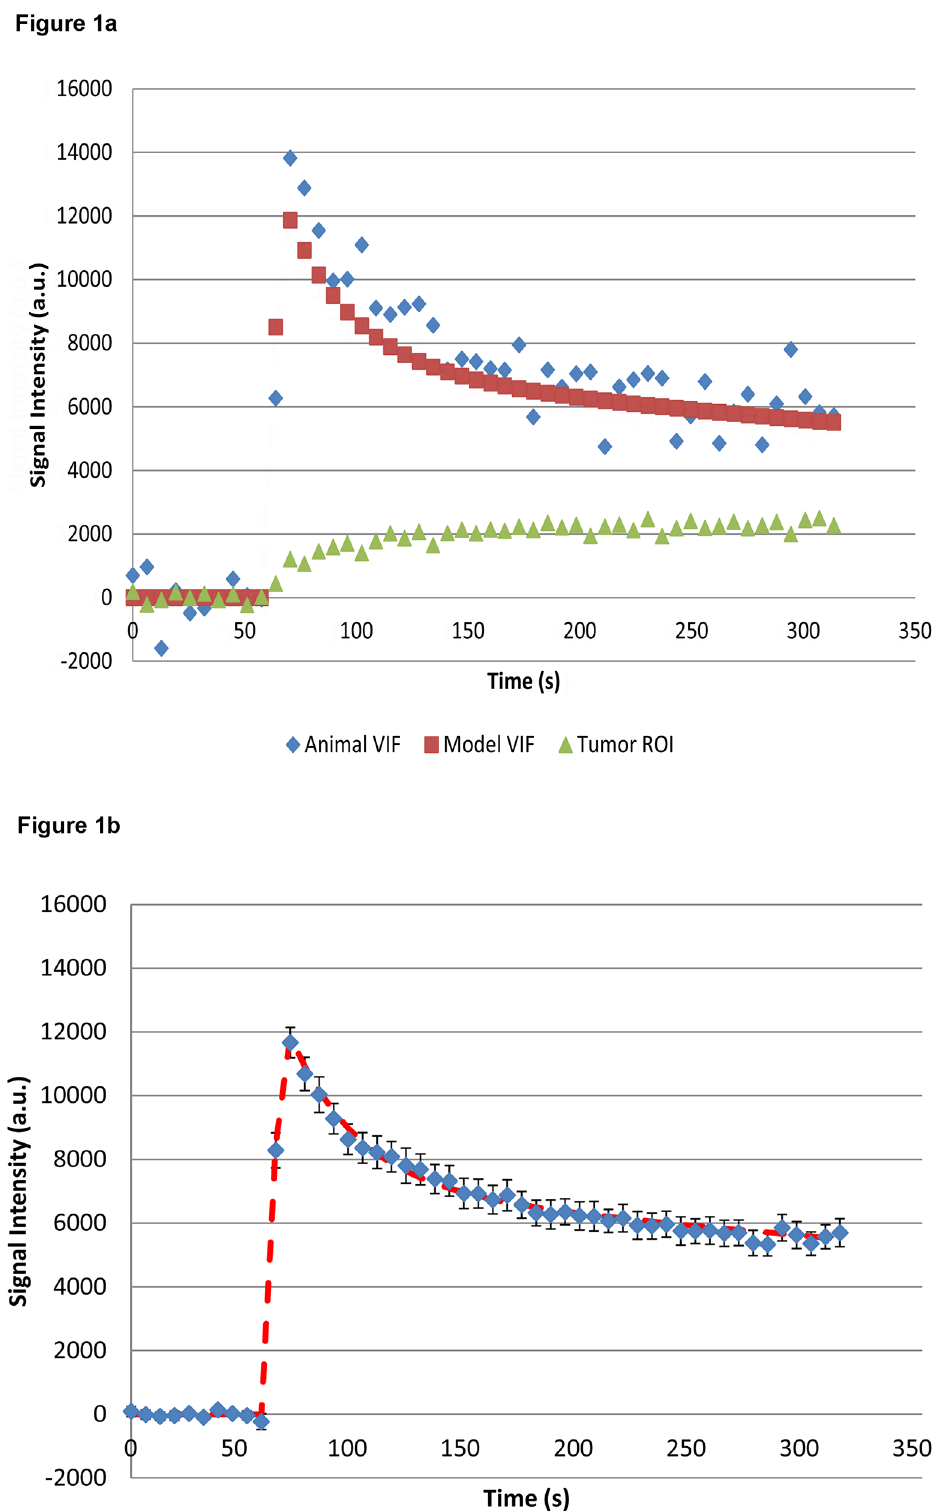
Fig 1. Example of signal intensity profiles. A) Vascular input function (VIF) from a representative individual animal (blue), and population average (red). Green symbols: tumor whole ROI data. Y-axis in units of signal intensity change from baseline, Δ SI . B) Average signal intensity change (VIF) from all animals and